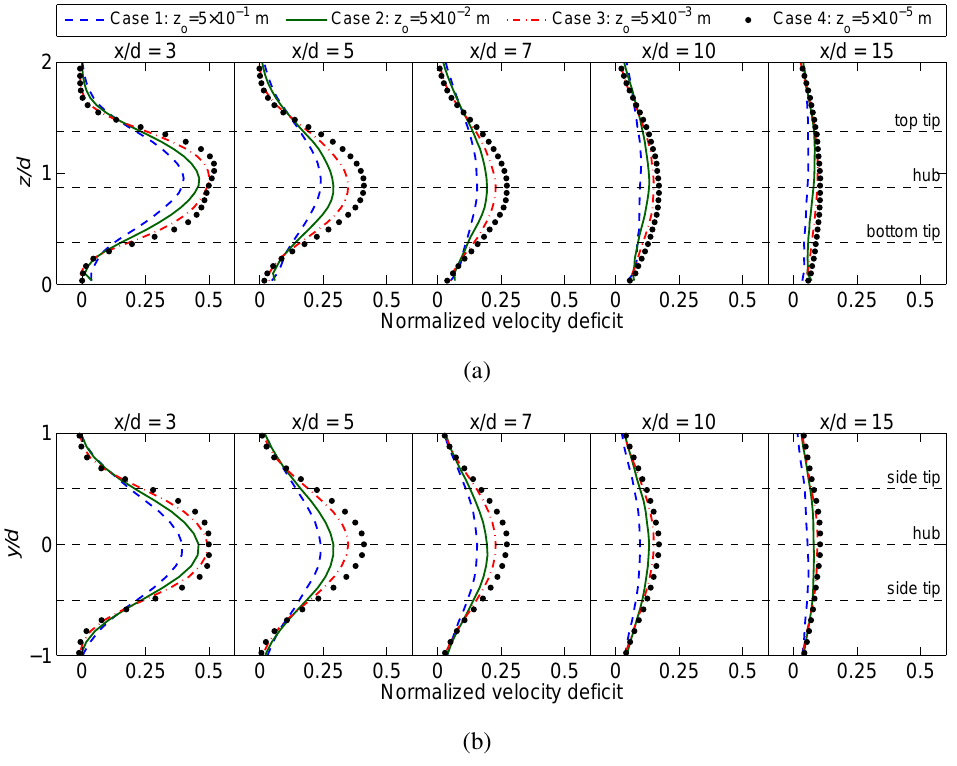
Figure 5. Comparison of vertical ( a ) and lateral ( b ) profiles of the normalized velocity deficit ∆ u/u through the hub level of stand-alone turbines installed on flat surfaces with hub different roughness